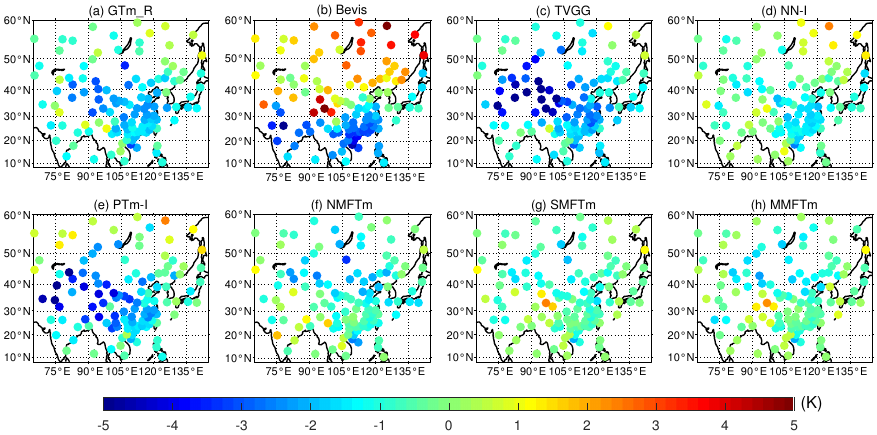
Figure 10. Distribution of S_MBE for different models tested by radiosonde data from 2016 to 2018 ( a – h